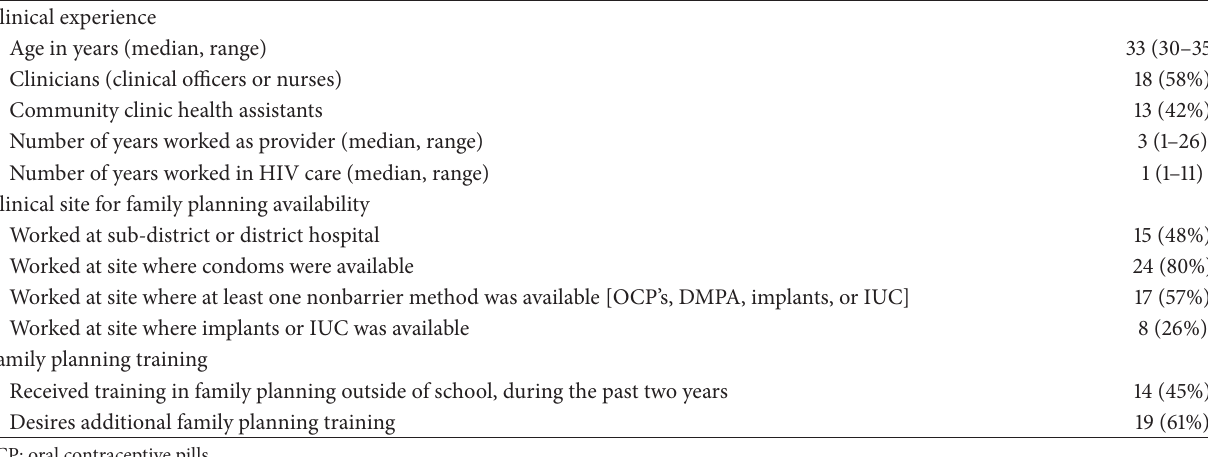
Table 1: Demographics and clinical context of HIV care providers ( 𝑁 = 31